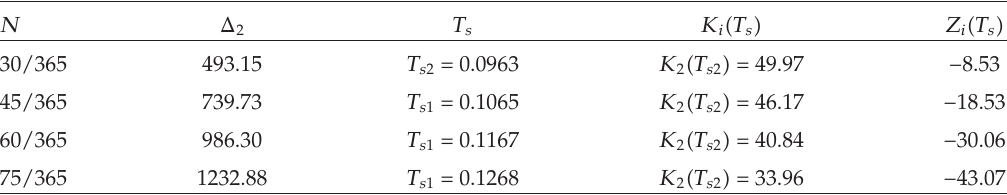
Table 2: Optimal solution for extended credit period.